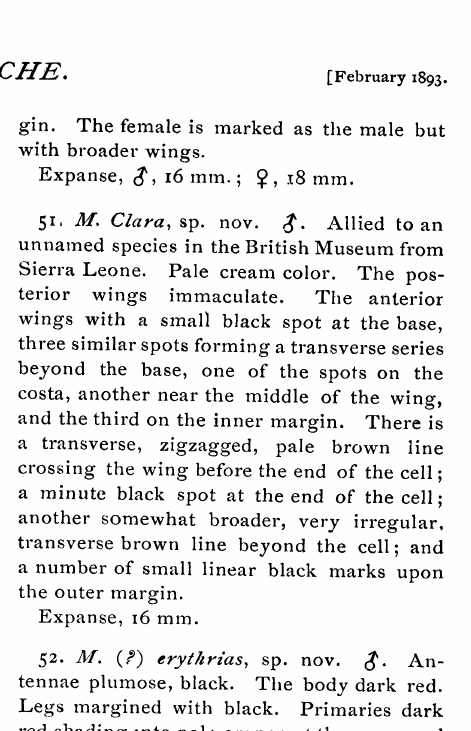
tennae plumose, black. The body dark red. Legs margined with black. Primaries dark red shading nto pale orange at the apex, and the outer margin uniformly fringed with dark